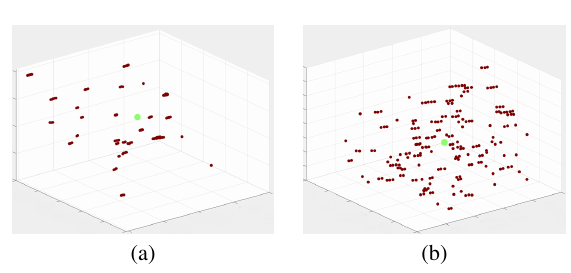
Figure 12: Raw point cloud of 20 m 3 relatively far from terrain containing only noise, a) sparse noise, b) dense noise relatively close to the terrain than a); red: noise points and green: centroid